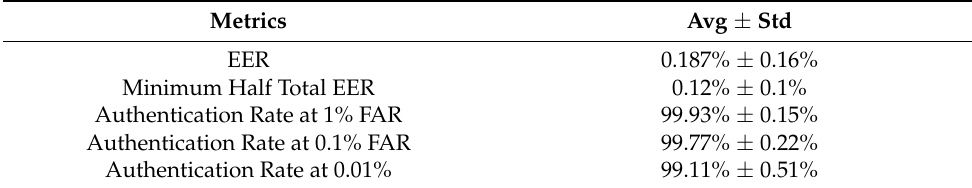
Table 10. Authentication System Results (EER).